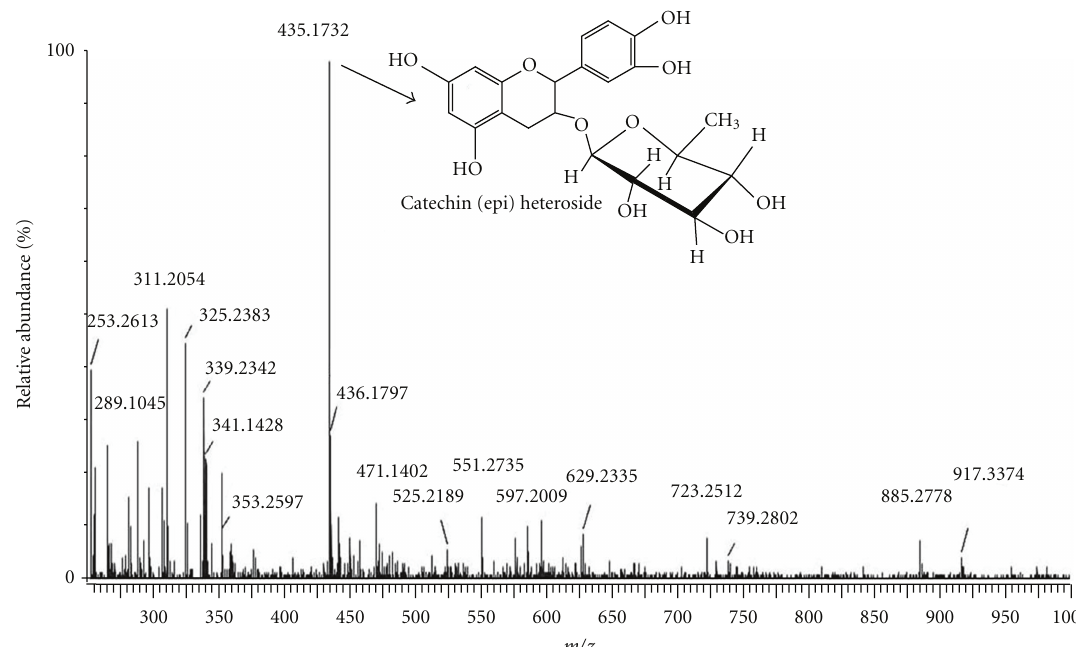
Figure 1: ESI/MS negative mode mass spectra fingerprint of the tannins of R. mangle concentrated in the buthanolic fraction (RM). The molecule presented is a condensed tannin monomer which is the relative major molecule in RM identified as catechin (epi) heteroside.